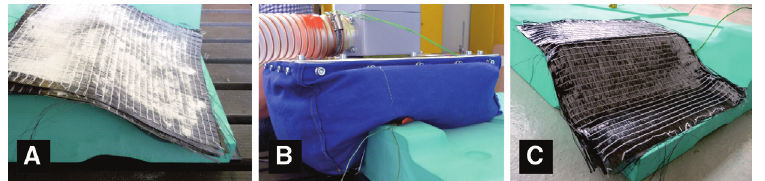
Figure 15 First preforming with a prototype of FormHand. Two layers of carbon fiber textile are preformed with hotmelt adhesive. Left: application of hotmelt adhesive, middle: draping and fixing of textile layer, right: preformed textile